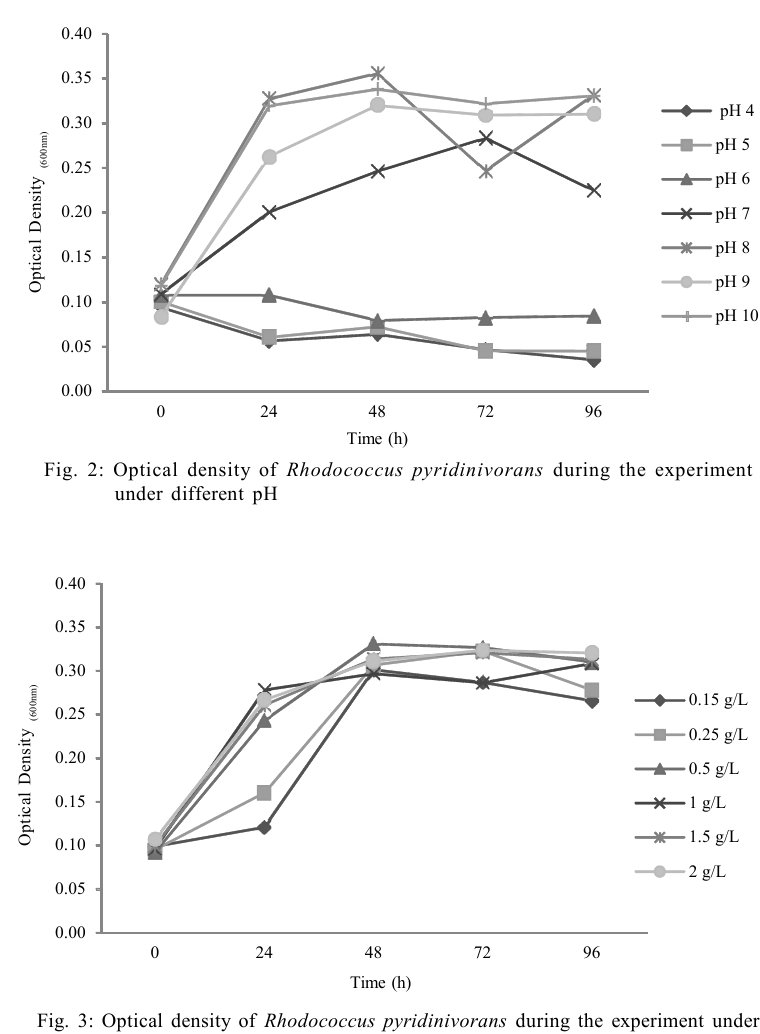
Fig. 3: Optical density of Rhodococcus pyridinivorans during the experiment under different phosphate